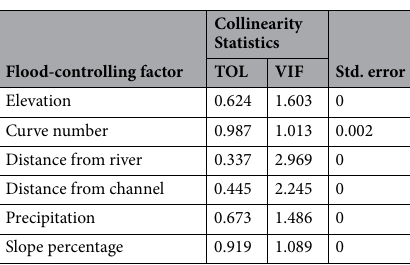
Flood-controlling factor